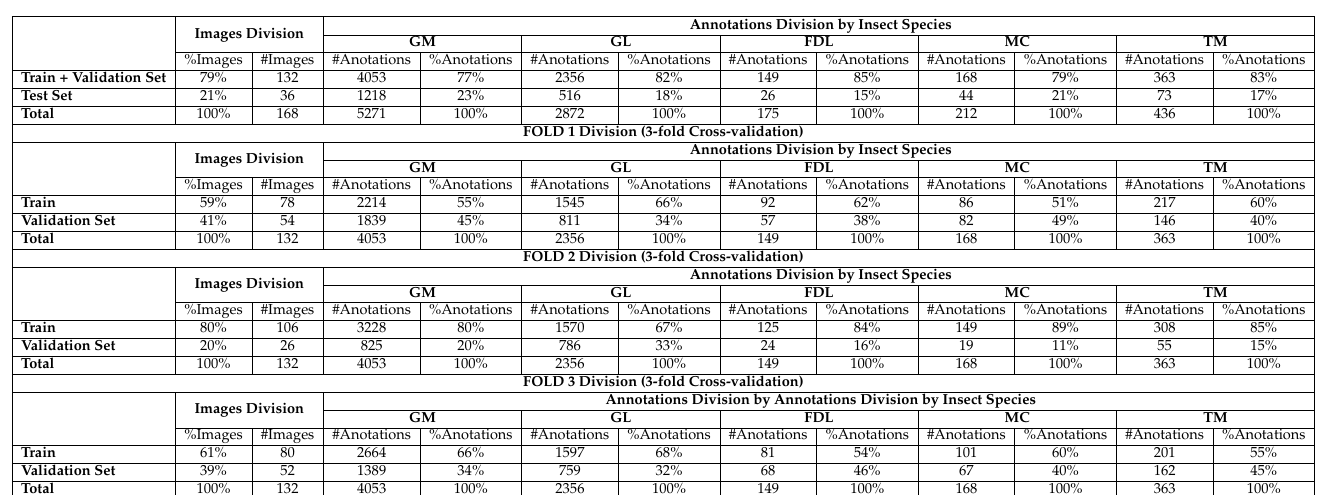
Table A1. Dataset division: stratification of insect annotations division by insect species for the different